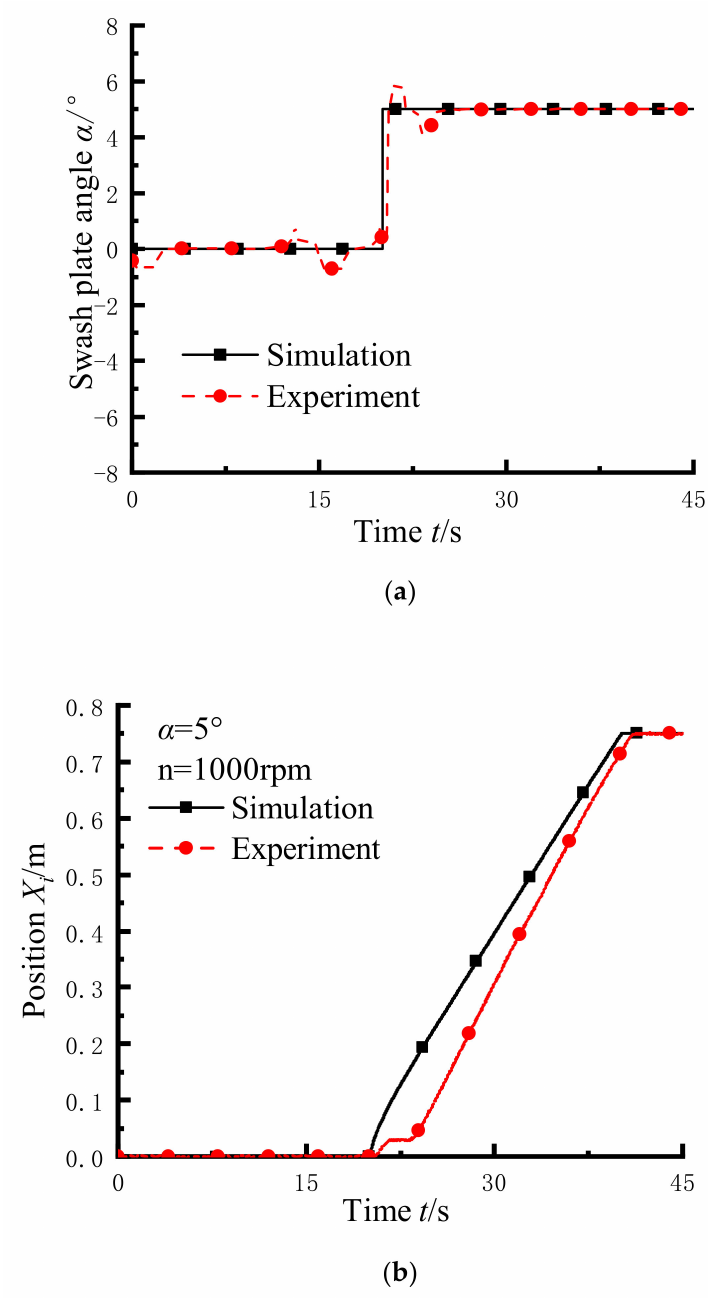
Figure 9. ( a ) The change in inclination angle with time ( b ) The change in load position with time. Formula (17) is used to calculate the energy consumed by the motor. Under the same conditions, the simulated and experimental motor energy-consumption figures are shown in Figure